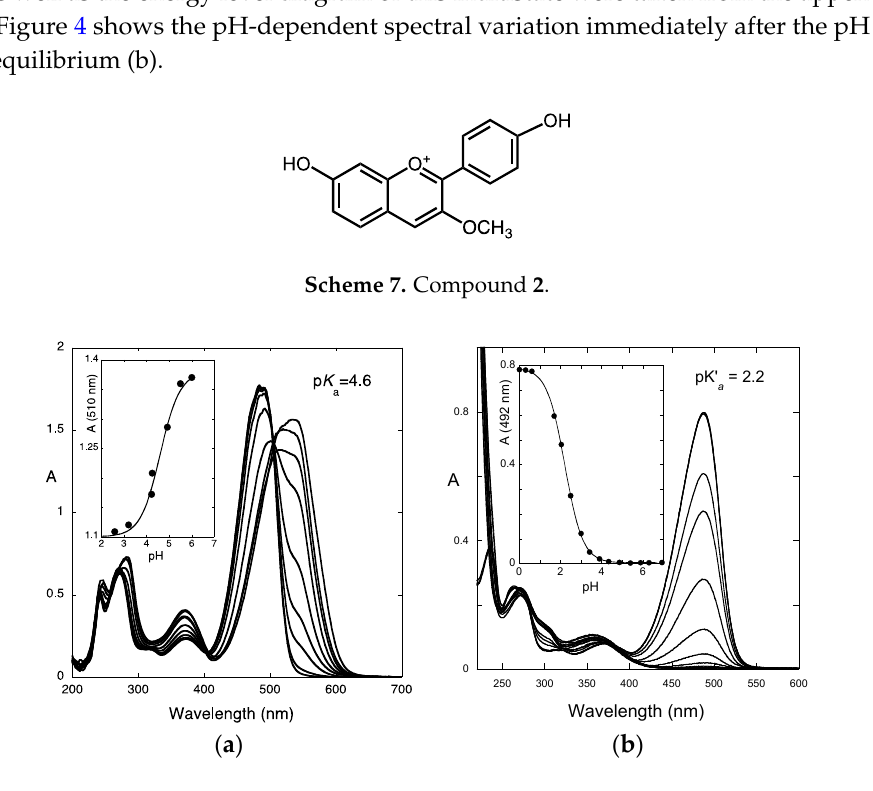
Figure 5. ( a ) Spectral variations observed upon a direct pH jump from 1 to 4.9; ( b ) pH dependence of the kinetic process controlled by the hydration reaction followed by stopped flow: (•) direct pH jumps;